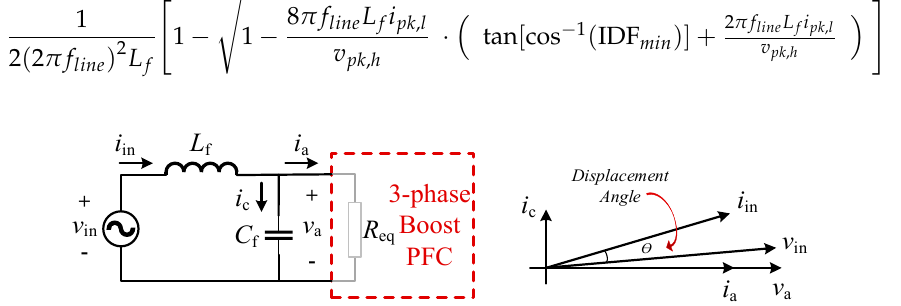
Figure 4. Distortion of grid side input phase current due to a single LC filter stage before a PFC circuit.